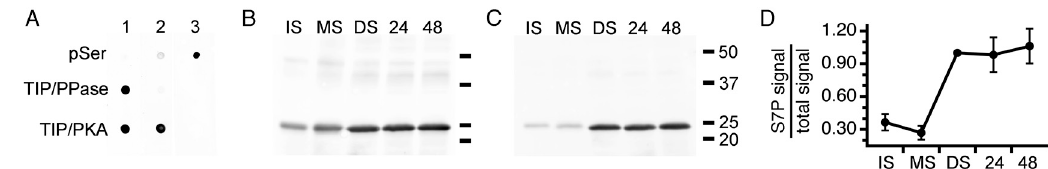
Figure 5. Immunodetection of PvTIP3;1 phosphorylated at Ser7. ( A ) Dot blots of a phosphoserine- bearing protein mix (pSer) and of purified PvTIP3;1 treated with either lambda protein phosphatase (TIP / PPase) or protein kinase A catalytic subunit (TIP / PKA). Blots were immunolabeled with aTIPnt13C (lane 1), aTIPnt13C_S7P (lane 2), or phosphoserine (lane 3) antisera to test antibody specificity. Western immunoblots using ( B ) aTIPnt13C or ( C ) aTIPnt13C_S7P antisera. Blot lanes: IS, immature seed; MS, mature seed; DS, dry seed; 24, seed imbibed for 24 h; 48, seed imbibed for 48 h. Position of molecular weight markers (bars) with kDa values indicated to the right of panel C . ( D ) Graph showing ratio of aTIPnt13C_S7P to aTIPnt13C antisera labeling. Results displayed as the average of four experiments ± one standard deviation of the sample, normalized so that the labeling ratio is 1:1 for the dry seed fraction. Horizontal axis indicates seed fractions as in B and C .